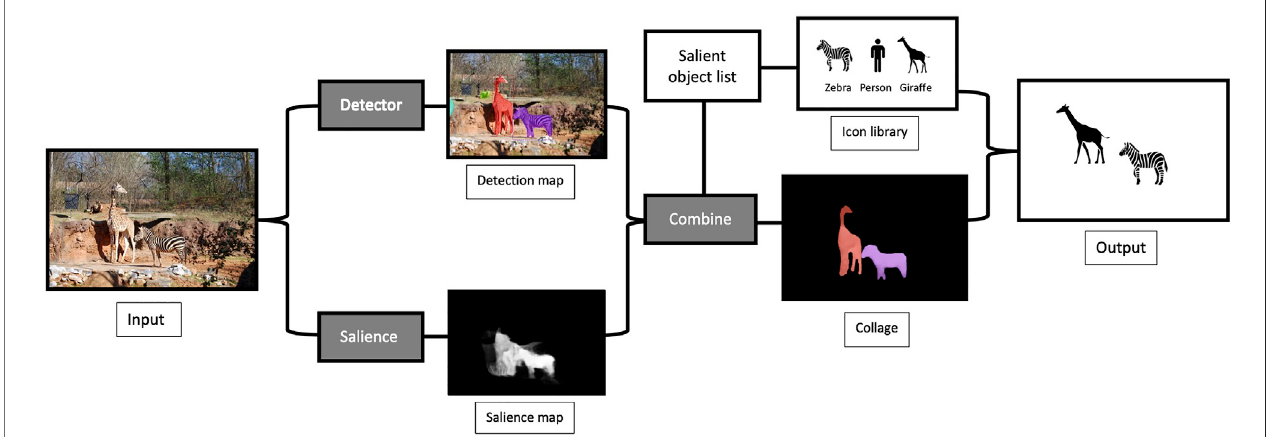
FIGURE2| Thealgorithminoverview,fromvisualtotactileimages. Theinputimageattheleftisprocessedtoproducebothadetectionandasaliencemap.These are combined into a collage, with a salient object list to call up the icons in the library. The output image places the relevant icons into representative spatial locations in the